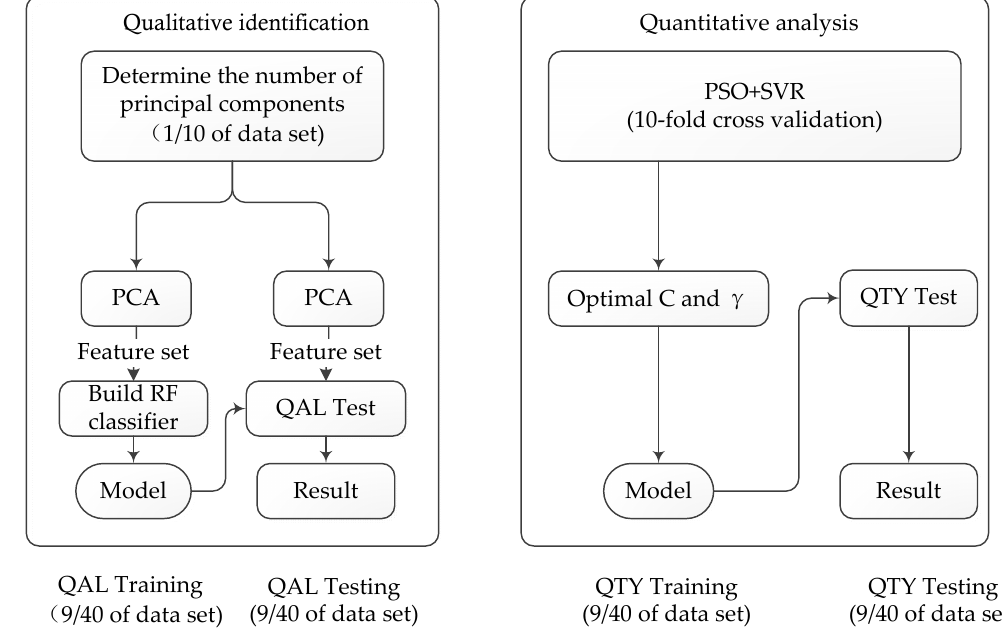
Figure 1. Gas mixture analysis method.